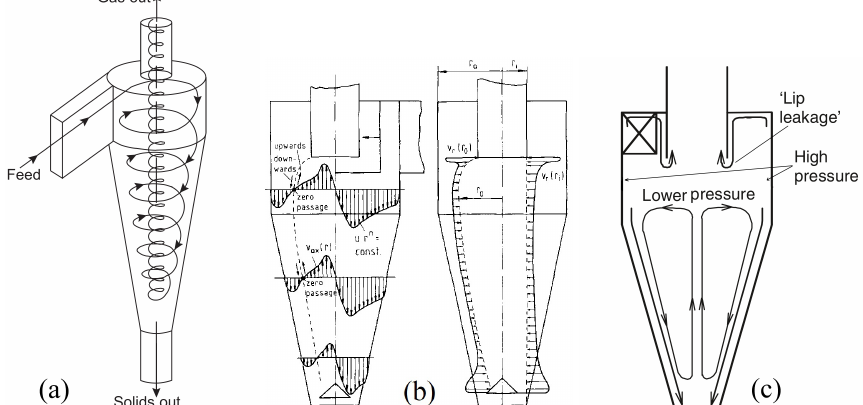
Figure 1. ( a ) Schematic drawing of a conical reverse-flow cyclone separator illustrating the basic operating principle and the presence of a double vortex inside the cyclone [21], reproduced with permission from G. Towler and R. Sinnott, Specification and design of solids-handling equipment, published by Elsevier, 2013. ( b ) Qualitative patterns of axial, tangential, and radial velocity components of the gas-flow field in cyclones (right) [22], reproduced with permission from M. Trefz and E. Muschelknautz, Extended cyclone theory for gas flows with high solids concentrations, published by John Wiley and Sons, 1993. ( c ) The secondary flow pattern caused by the swirl and pressure gradients in the cyclone [19], reproduced with permission from A. Hoffmann and L. Stein, Gas Cyclones and Swirl Tubes: Principles, Design and Operation; published by Springer Nature,